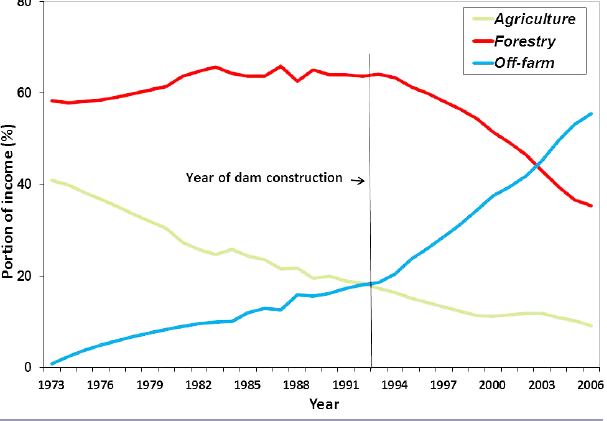
Fig. 5 . Changes in income from agriculture, forestry, and off- farm activities in Daxi village, Anji, Zhejiang, 1973 to 2006 (modified from Gutierrez et al. 2009, based on unpublished statistics obtained from the Daxi village's handwritten